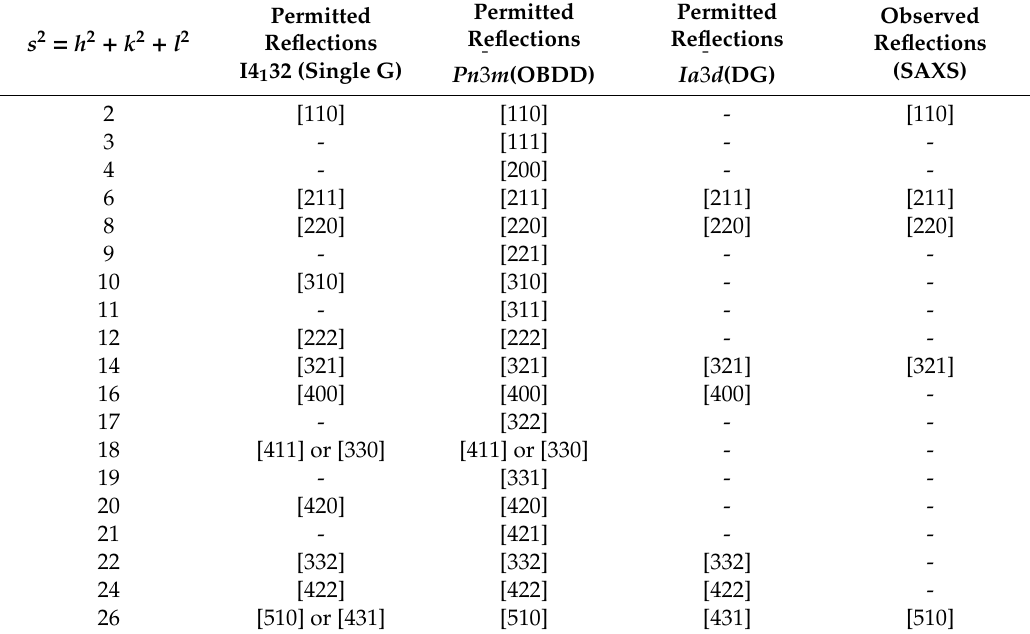
Table 3. Permitted and experimentally observed reflections of the I4 1 32 cubic space group (according to International Tables of Crystallography). Comparison with the permitted reflections of Pn 3 m (OBDD) and Ia 3 d